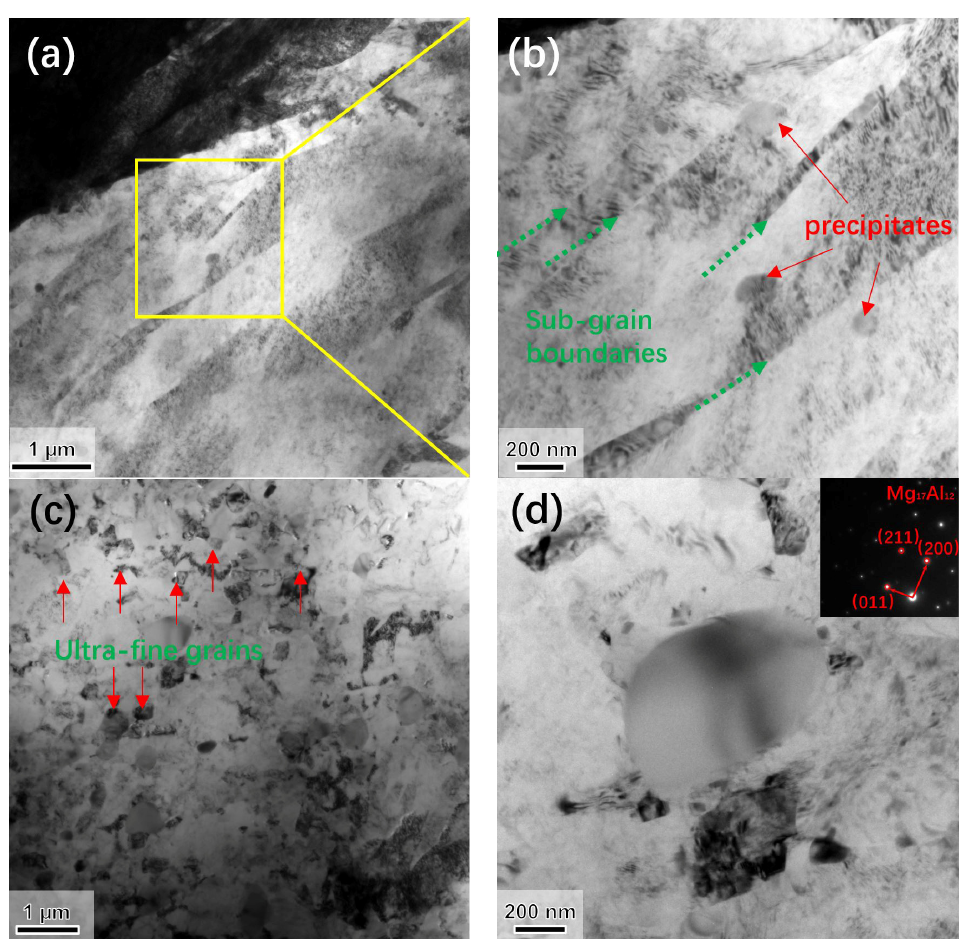
Figure 7. Transmission electron microscope (TEM) images of ( a , b ) unDRXed and ( c ) DRXed microstructure of CRed AZ80 alloy; ( d ) image of precipitate in CRed AZ80 alloy (inset in ( d ): Mg 17 Al 12 diffraction pattern).